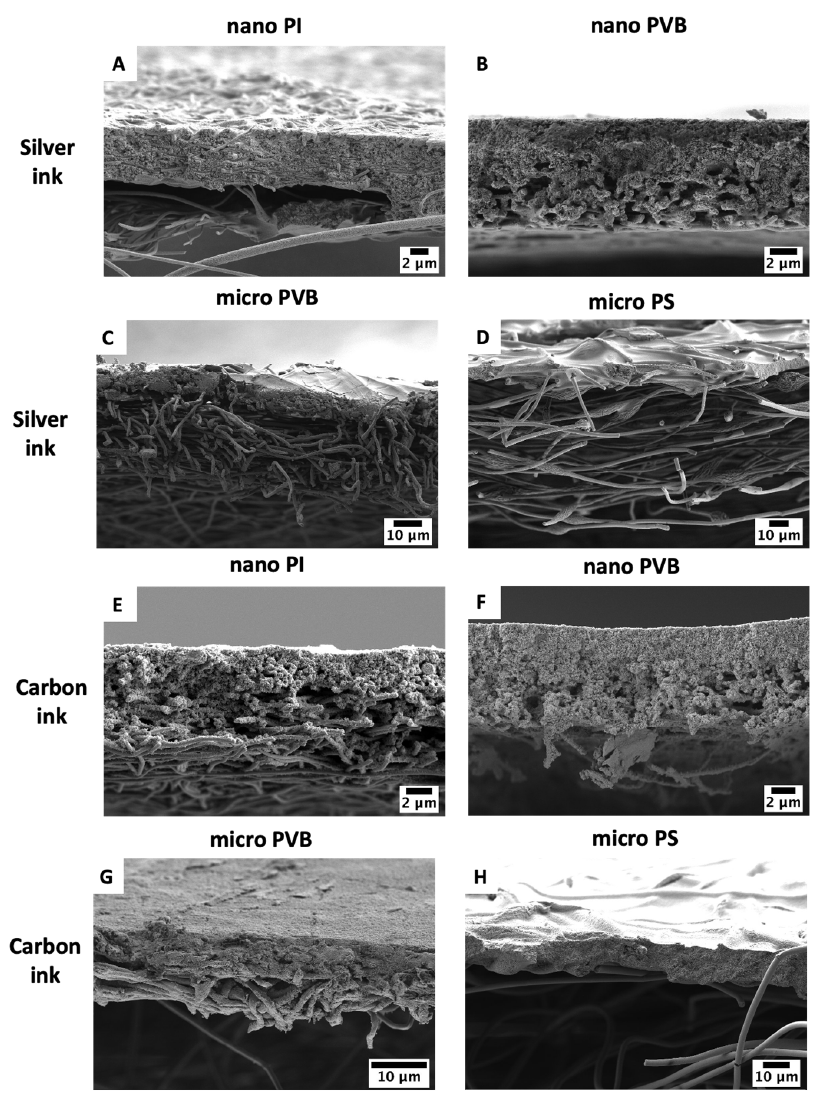
Figure 5. SEM micrographs of cross-section of sintered samples of electrospun membranes based on: ( A , C ) nano PI and ( B , D ) nano PVB, ( E , G ) micro PVB and ( F , H ) micro PS printed with two layers of silver and carbon ink, respectively.